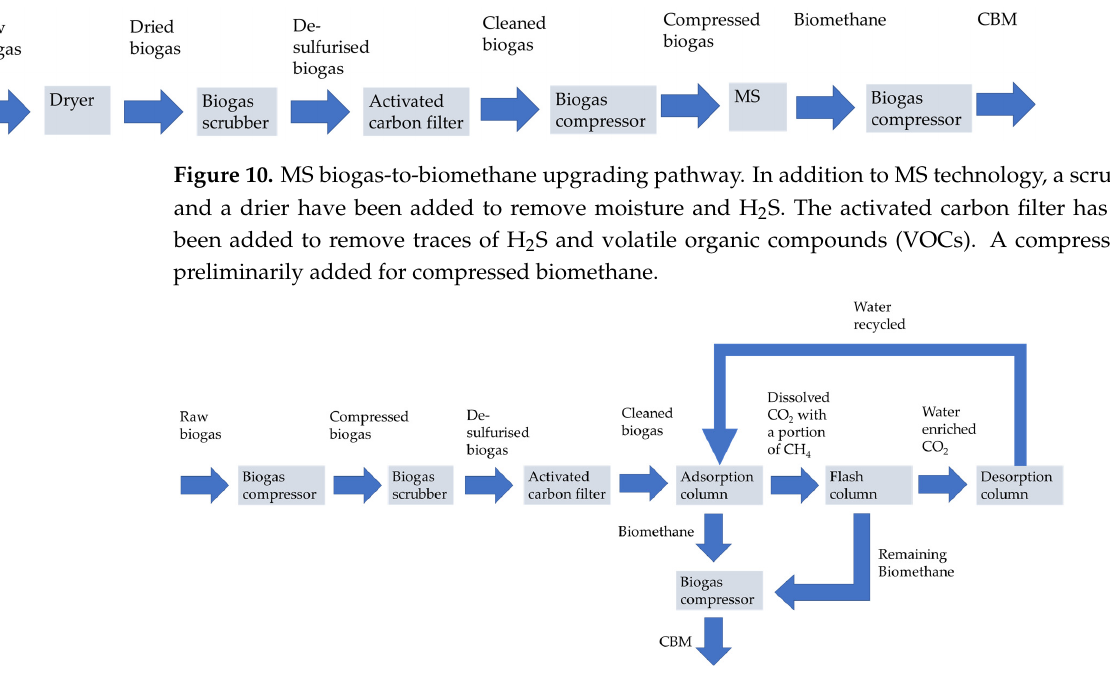
Figure 11. WS biogas-to-biomethane upgrading pathway. In addition to WS technology, a scrubber and an activated carbon filter have been added to remove H 2 S and traces of volatile organic com- pounds (VOCs). The water is recycled for optimal and stable operation. A compressor is preliminarily added for compressed